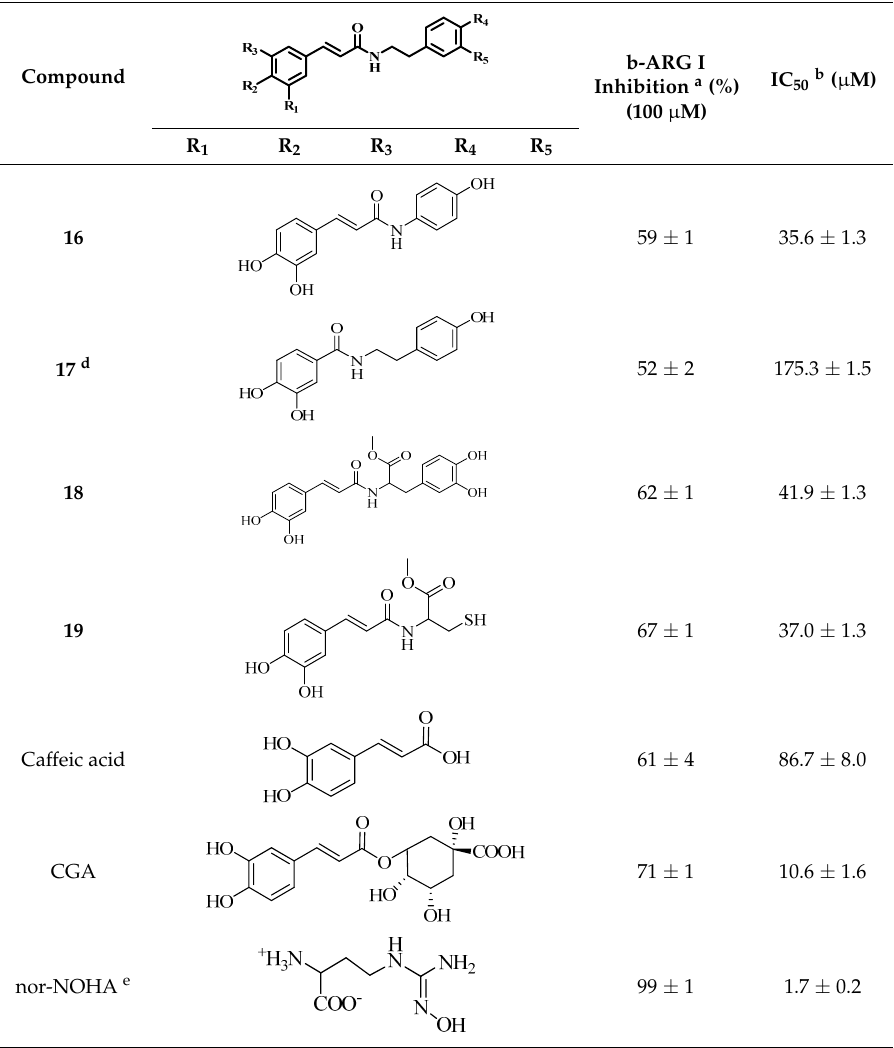
Table 1. Cont. Table 1. Structures of the synthesized compounds and their inhibitory potencies toward b-ARG